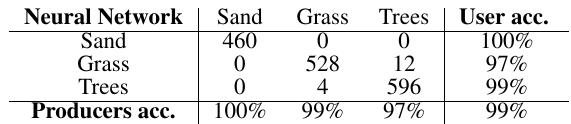
Table 3. Confusion matrix for the neural network model classification on 2021-09-07. Here, ’acc.’ stands for accuracy